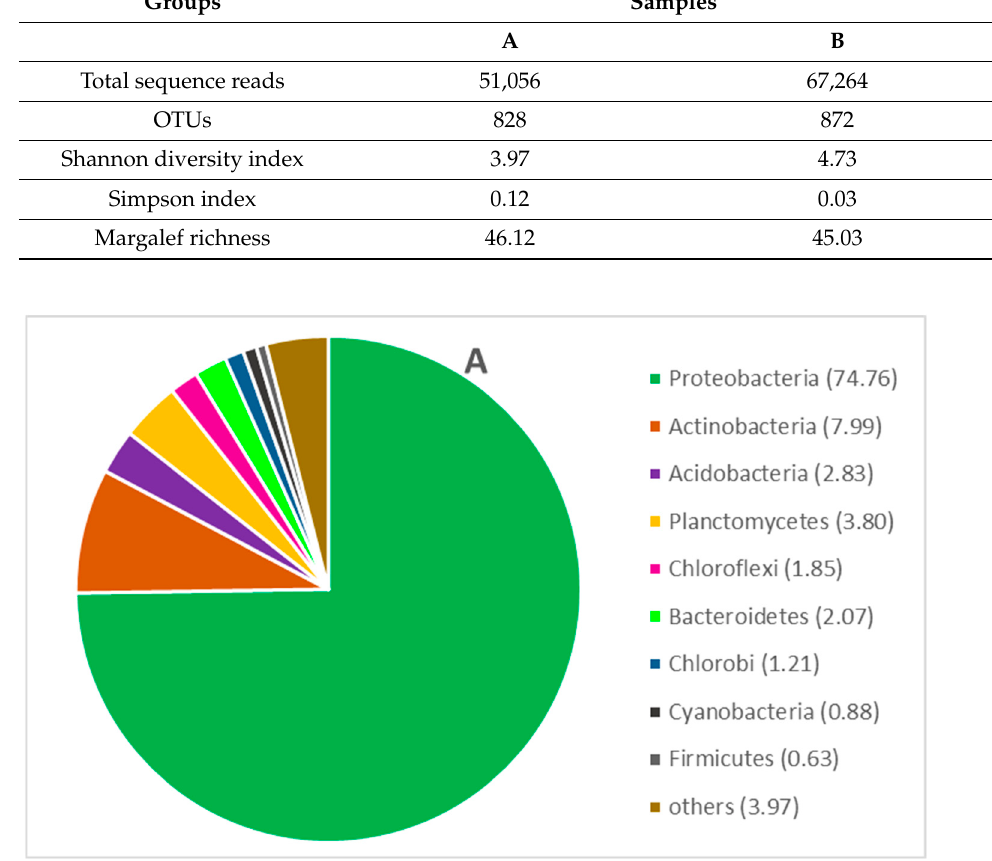
Table 3. Diversity indices and microbial community structure at phylum level in the two types of PUR foam samples.